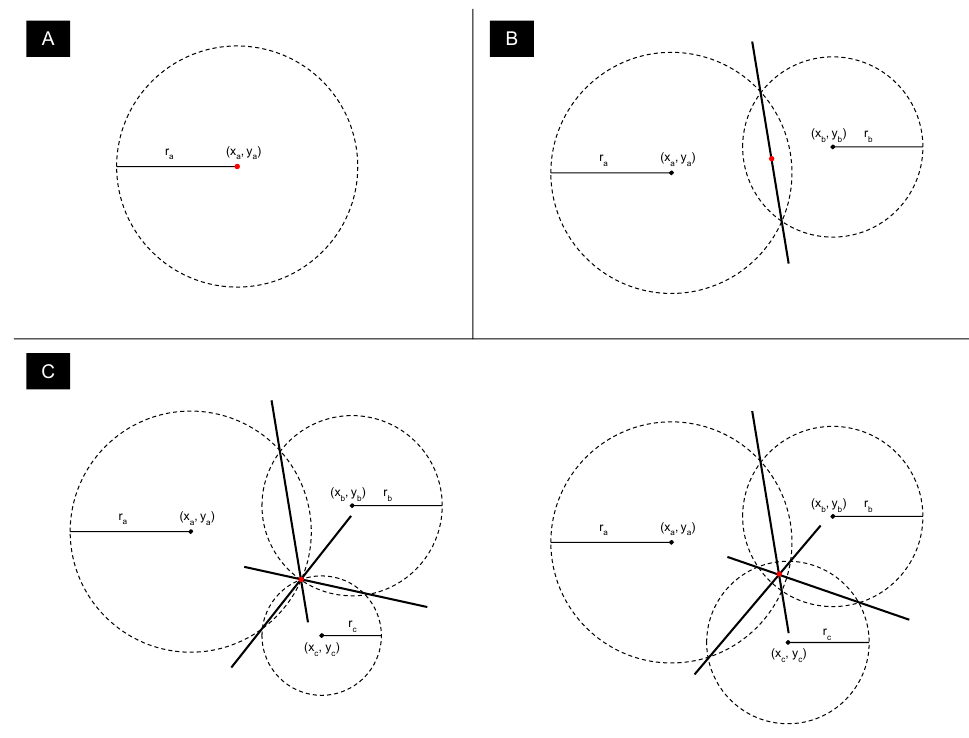
Figure 1. Case ( A ): 1 detected beacon; Case ( B ): 2 detected beacons; Case ( C ): 3 detected